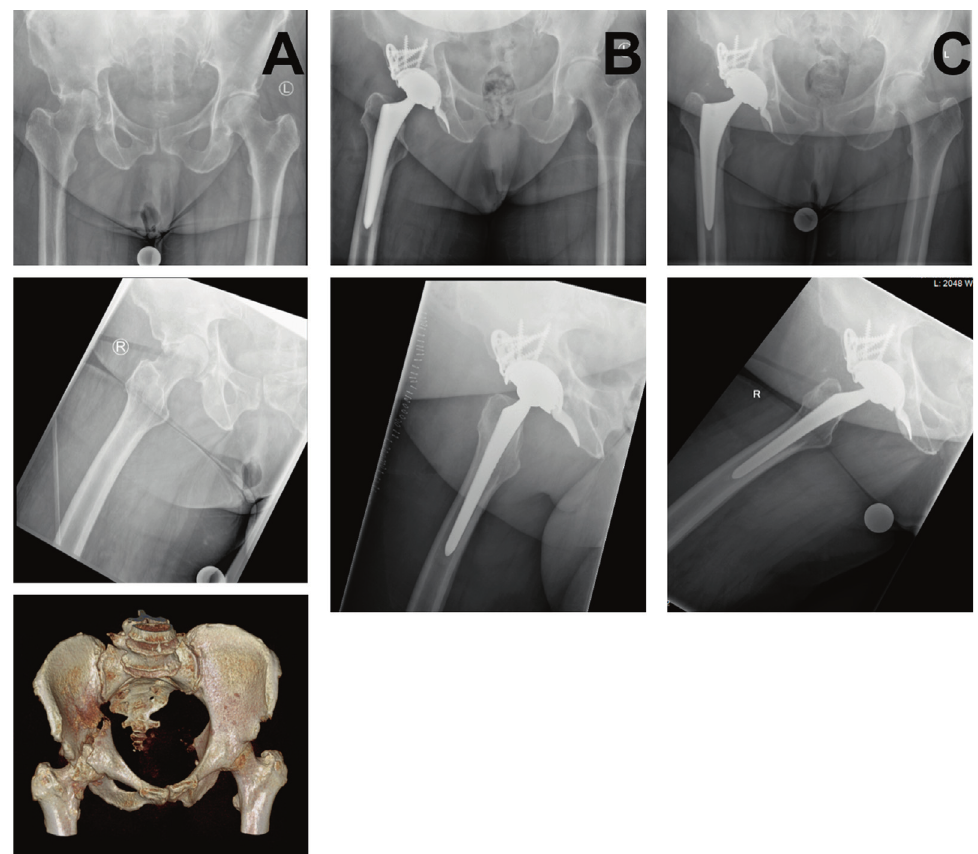
Figure 4. Fracture of the right acetabulum of a 67-year-old female. The patient reported to the emergency room four weeks delayed, upon admission impaction of the femoral head and the pattern of a two-column fracture was visible (column A). Significant comorbidities were missing, the individualized treatment plan was defined as acute total hip replacement (THR) with application of the Burch-Schneider reinforcement ring. Follow-up X-rays at two weeks (column B) and at three months (column C) are